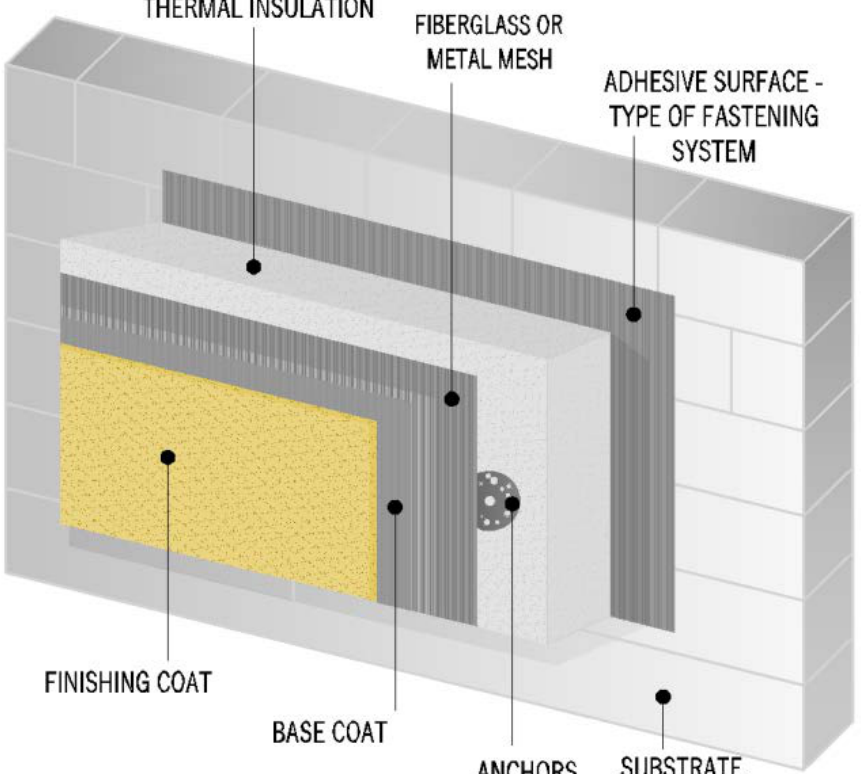
Figure 1. Schematic example of ETICS available in the European market. Beneficial long-term properties combined with excellent protection against blowing rain and high thermal insulation quality are the reasons why ETICS has become so popular in Central Europe. The multilayer exterior coating was evaluated as a less vulnerable solution in comparison with traditional plaster coatings [2]. However, earlier ETICS applications revealed particularly poor resistance to impact and biological infestation of plasters [8]. In the light of practical experience and theoretical studies, the durability of an insulation system depends largely on the properties of individual components, such as Styrofoam boards, priming layer, adhesive mortar and plaster layers, as well as on the way they are combined with one another. The weakest of these is exterior wall finish plaster, which causes defects such as cracking, flaking or peeling off the surface and, sometimes, some fragments falling off. Changes to the exterior wall finish surface due to microbial growth are generally accepted as ‘patina’ as long as they are uniformly distributed, while local contamination or algae concentrations are often evaluated as ‘visually adverse’ [2]—Figure